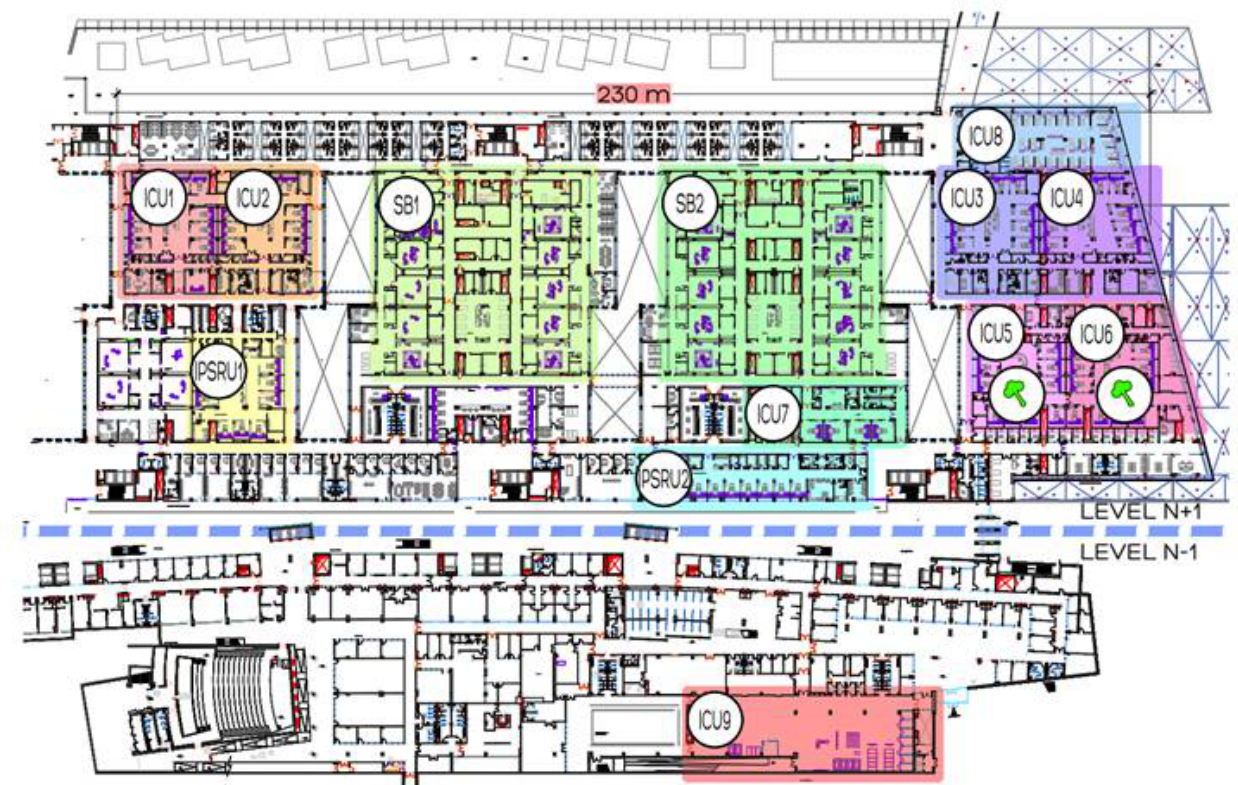
Figure 1. Map of Intensive Care Units (ICU), Intensive Post-Surgical Resuscitation Units (PSRU) and Operating Rooms (SB). Level of A. fumigatus conidia load obtained in ICUs 5 and 6 with 1 CFU/m 3 each one during the study period.